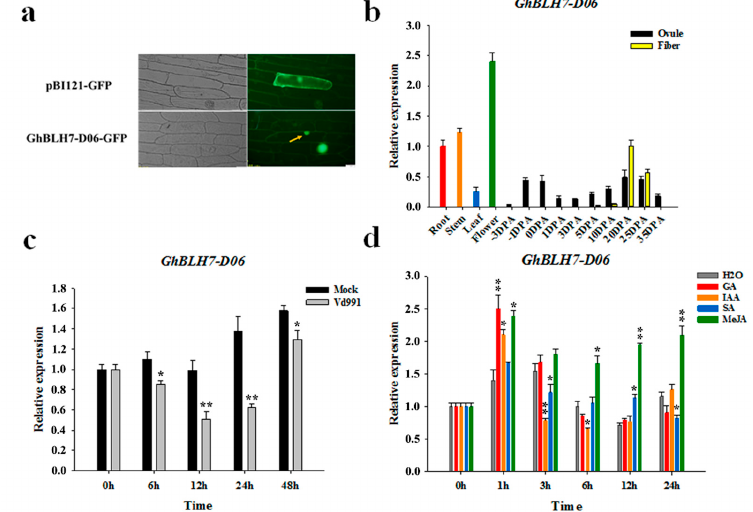
Figure 2. The expression patterns of GhBLH7-D06 in cotton: ( a ) the subcellular localization of GhBLH7-D06; ( b ) the expression level of GhBLH7-D06 in different tissues in TM-1; ( c ) the expression pattern of GhBLH7-D06 in response to V. dahliae ( Vd991 ) infection; and ( d ) the expression pattern of GhBLH7-D06 responds to phytohormones (GA, IAA, SA and MeJA). Error bars represent the standard deviation of three biological replicates. Asterisks indicate statistically significant differences, as determined by Student’s t -test (* p < 0.05; ** p <